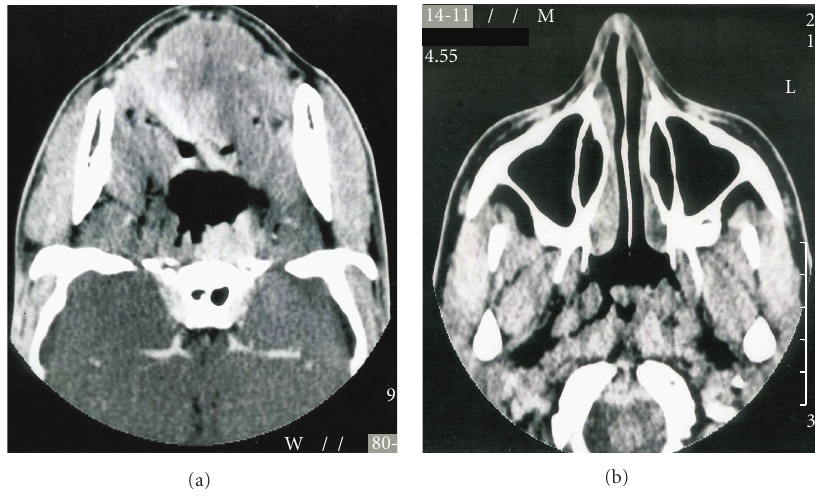
Figure 1: Facial CT: thickening of the left